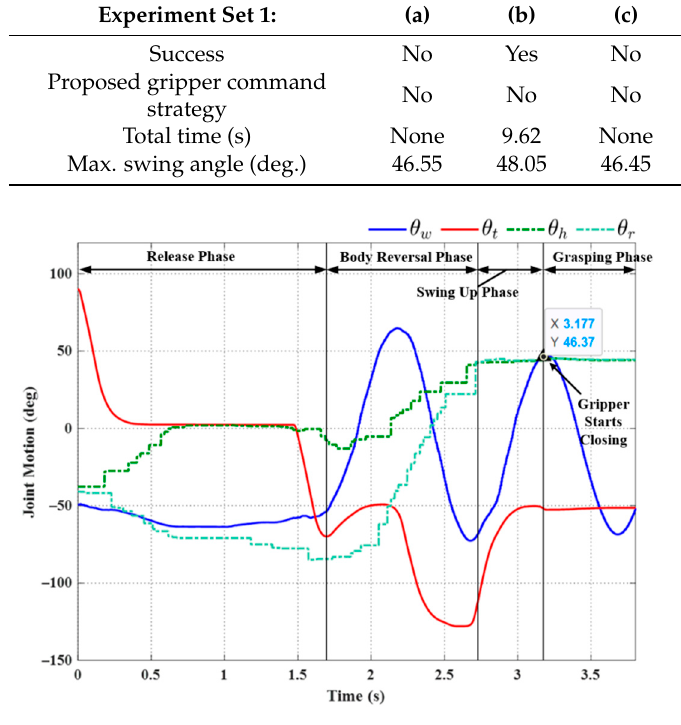
Figure 16. Experimental results: joint motion in Experiment (a).